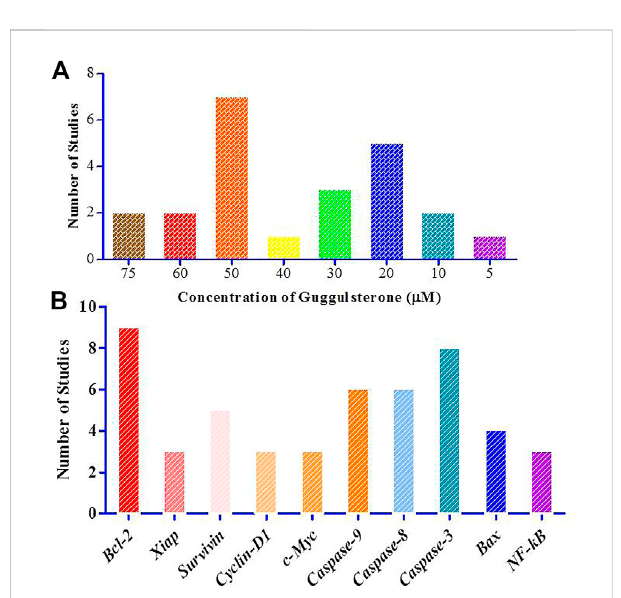
FIGURE 7 Graphical representation of the study characteristics and the observations (A) . Concentration of Guggulsterone used for the treatment of the various cancer in vitro in selected 23 studies; (B) . Number of studies that have shown the modulation of these major